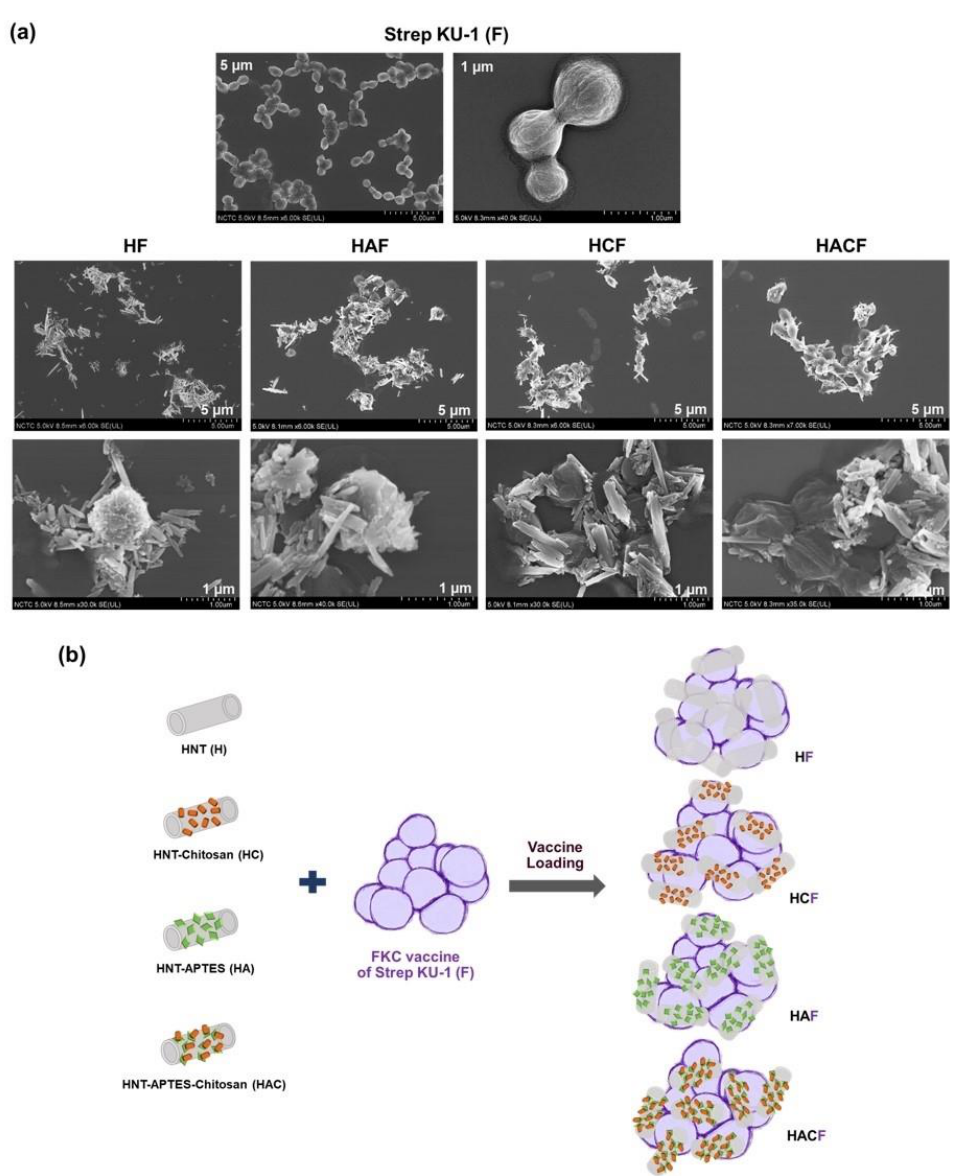
Figure 1. Scanning Electron Microscopy (SEM) observation and schematic diagram of Strep KU-1 and HNTs: ( a ) SEM images of the bared Strep KU-1 molecules (F) as well as the complexes of Strep KU-1 combined with HNTs (HF, HAF, HCF and HACF) at scale bars of 1 µm and 5 µm. ( b ) The schematic diagram proposing the surface binding characteristics of HNT moiety on the Strep KU-1 surface.